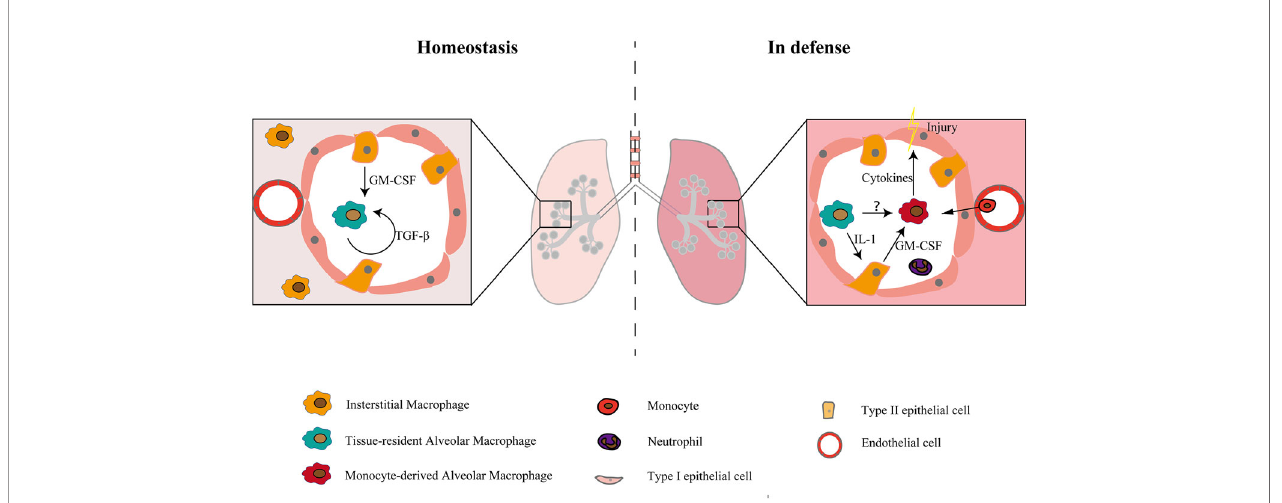
FIGURE 1 | Macrophage subsets in the steady state and in defense. There are two populations of macrophages in the physiological state and three populations of macrophages in the injury and in fl ammatory states. In the steady-state condition, the maturation and self-maintenance of TR-AMs rely on GM-CSF and TGF- b . When injury occurs, monocytes recruit to the alveolar lumen and develop into macrophages, constituting a second group of alveolar macrophages and causing tissue damage by releasing cytokines. TR-AMs can indirectly affect the functions of Mo-AMs and other myeloid cells by inducing epithelial cells to release GM-CSF (12). Whether there is a direct interaction between TR-AMs and Mo-AMs is still